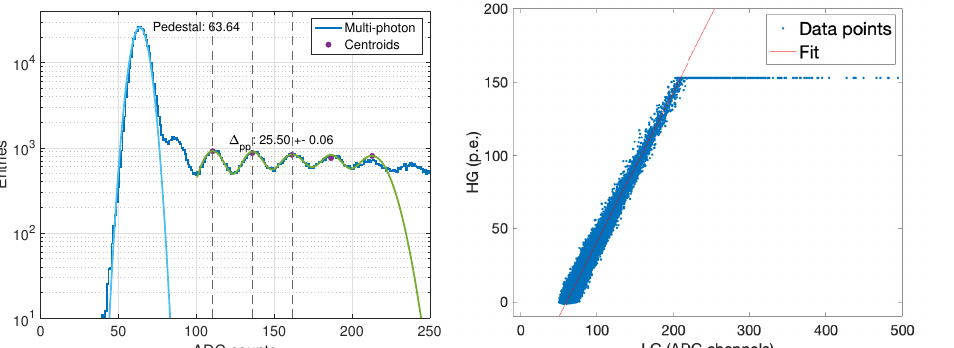
Figure 4. The spectrum on the ( left ) is an x-zoom of the spectrum in Figure 3 to appreciate the quality of the multi-photon and the fitting procedure. The HG signals, converted in ph-e, are correlated to the LG signals on the ( right ) plot.